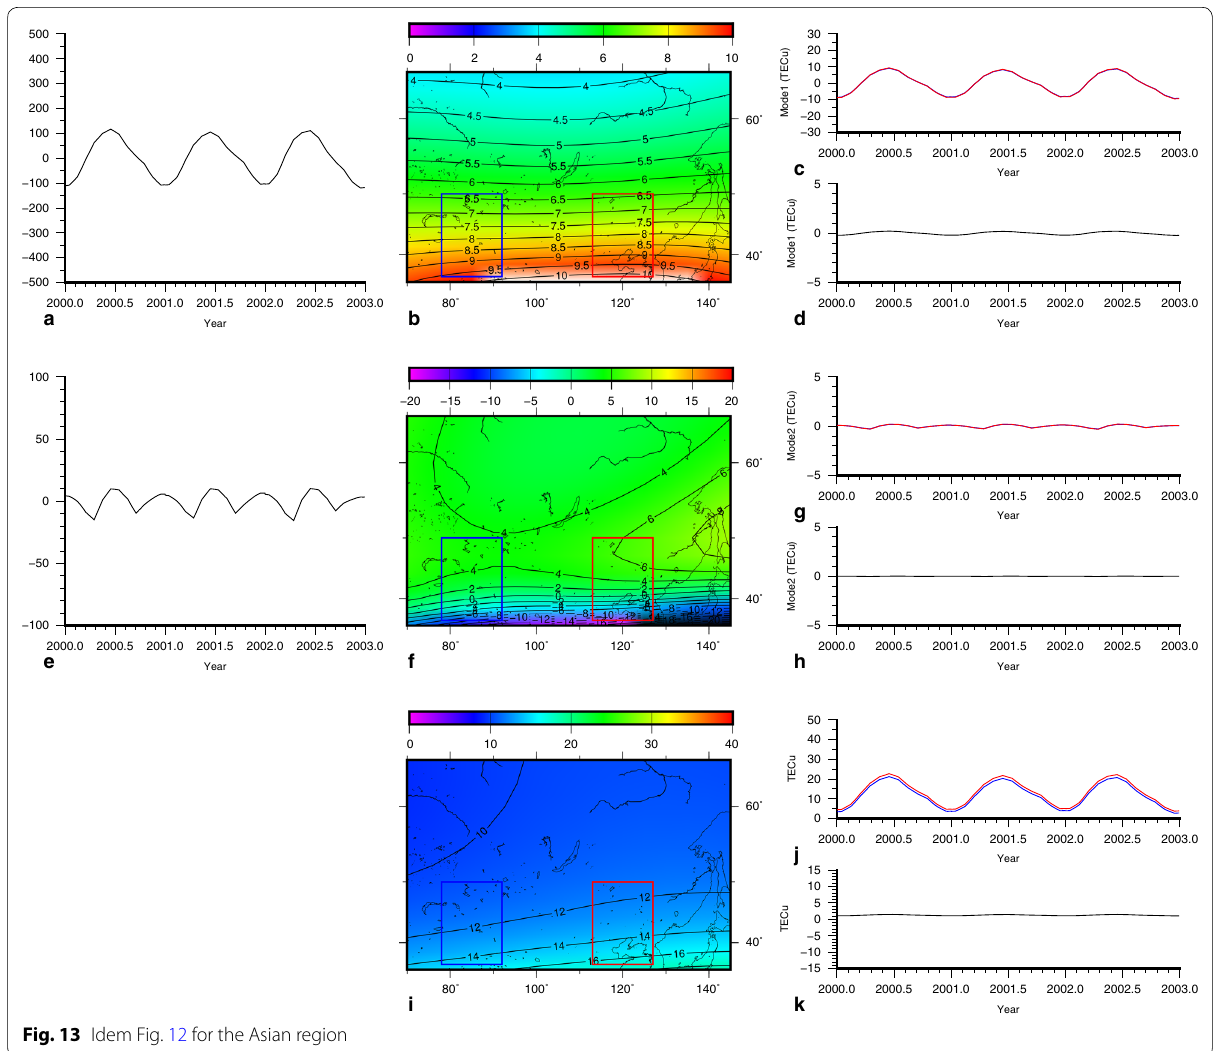
Fig. 13 Idem Fig. 12 for the Asian